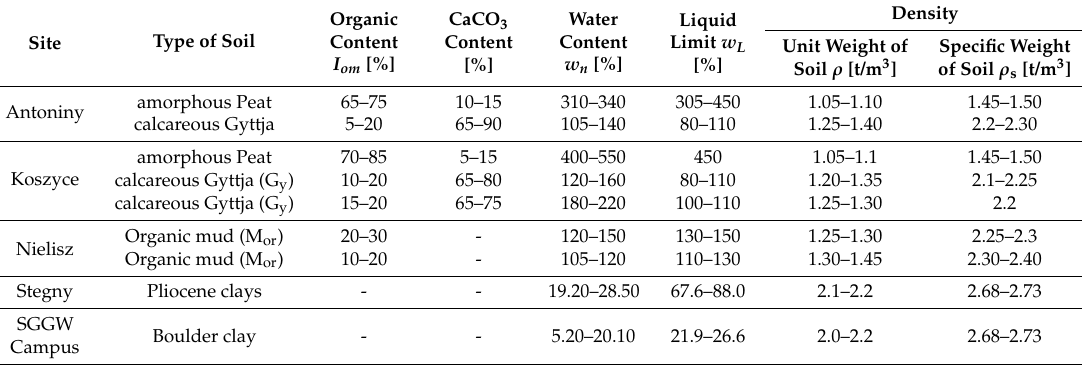
Table 3. Index properties of organic soils at the Antoniny, Koszyce, Nielisz, Stegny and SGGW Campus test